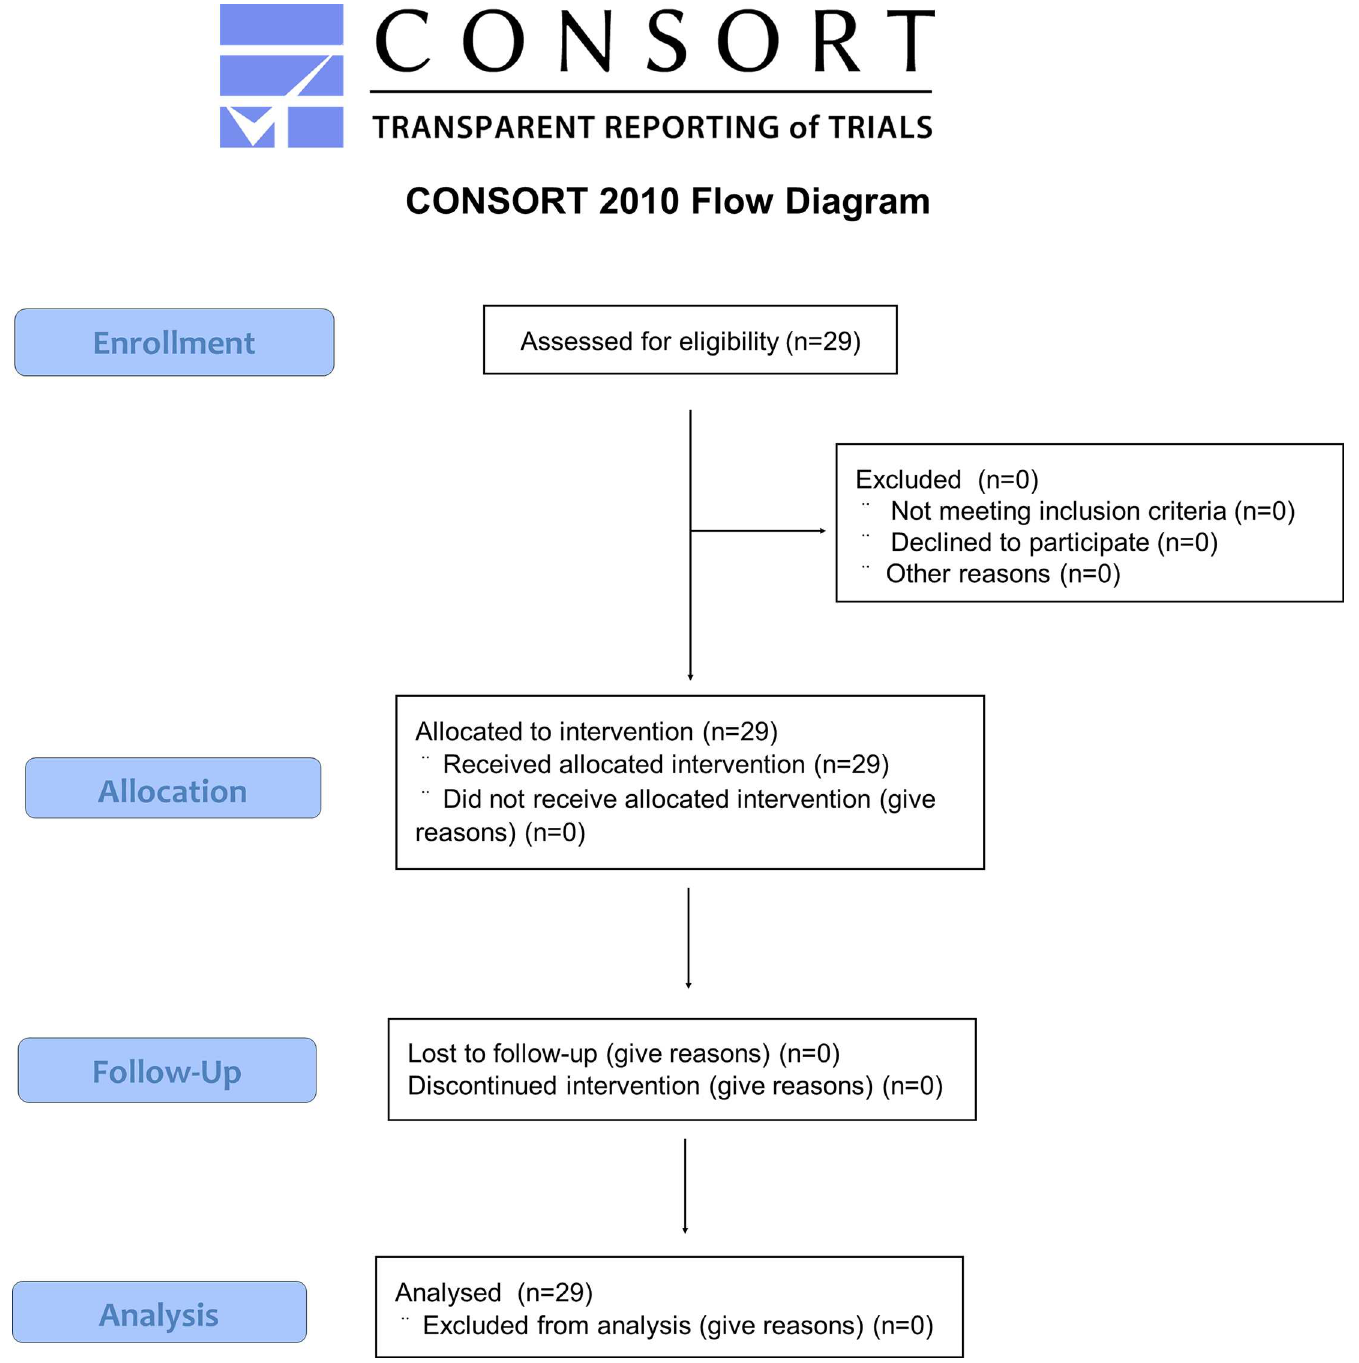
Fig 1. Study Protocol in this prospective observational case control